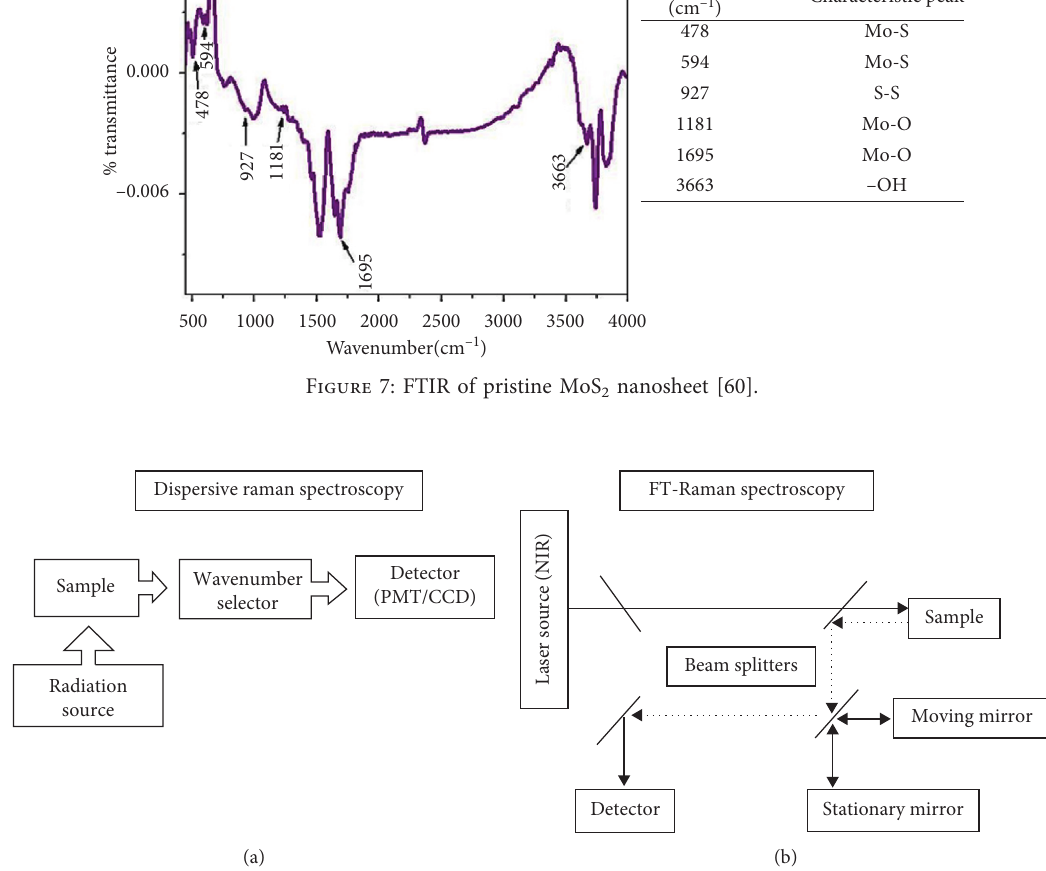
Figure 8: Basic instrumentation of (a) dispersive and (b) FT-Raman spectroscopy [88].